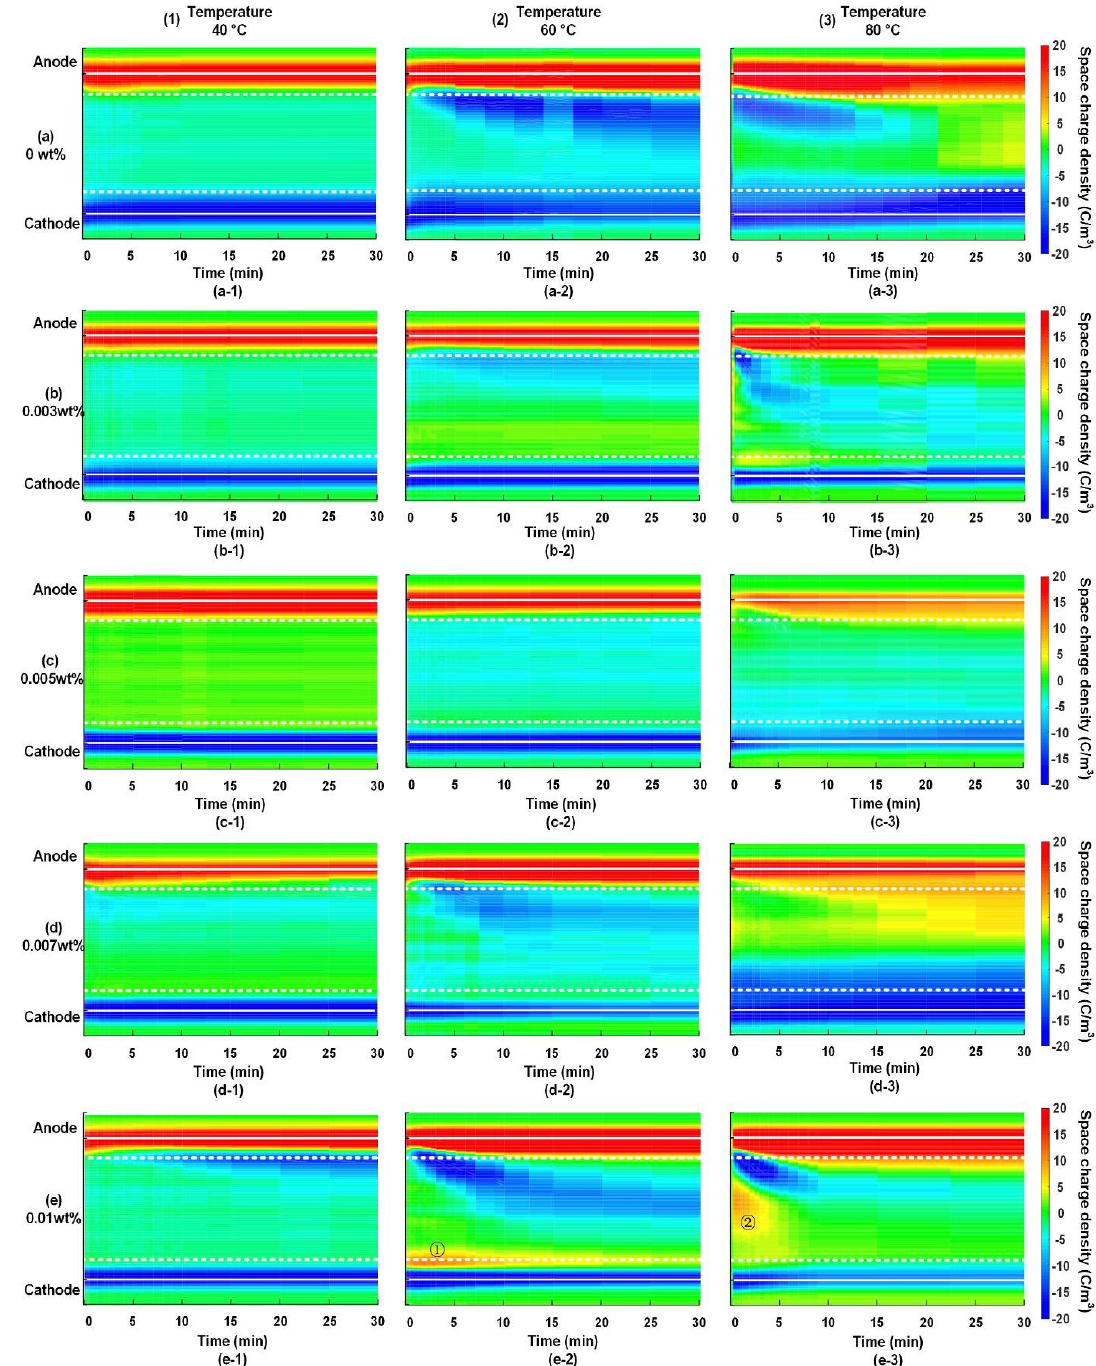
Figure 3. Space charge dynamic behaviors in graphene/LDPE composites with different filler content under +30 kV/mm at 40, 60 and 80 °C, respectively. ( a-1 – a-3 ) 0 wt %, ( b-1 – b-3 ) 0.003 wt %, ( c-1 – c-3 ) 0.005 wt %, ( d-1 – d-3 ) 0.007 wt %, and ( e-1 – e-3 ) 0.01 wt % graphene/LDPE nanocomposites.